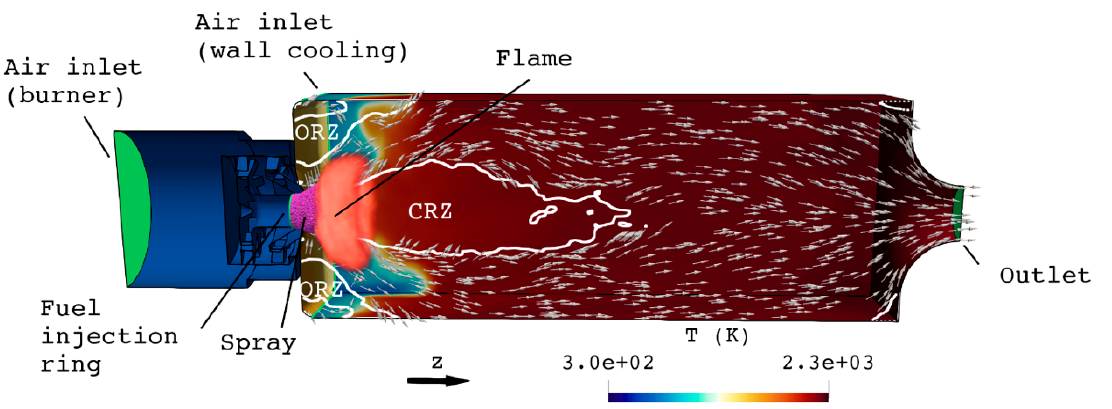
Figure 9. Centrally cut geometry with LES results. Inlets are green, and walls are colored by time- averaged temperature. The spray is colored in magenta, and the time-averaged flame is colored in light red. Arrows indicate mean velocity direction in the central plane inside the main flow cone (MFC). The central (CRZ) and outer (ORZ) recirculation zones are denoted by white contours.